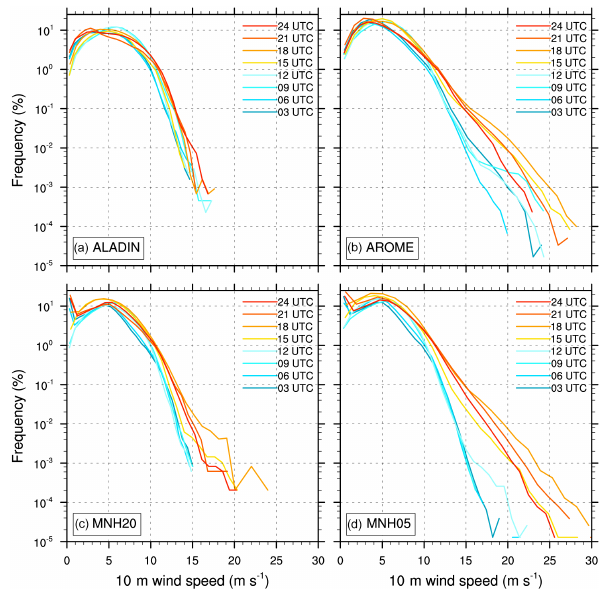
Figure 7. Probability density function of the 10m wind speed in June 2011 from (a) ALADIN, (b) AROME, (c) MNH20 and (d) MNH05.